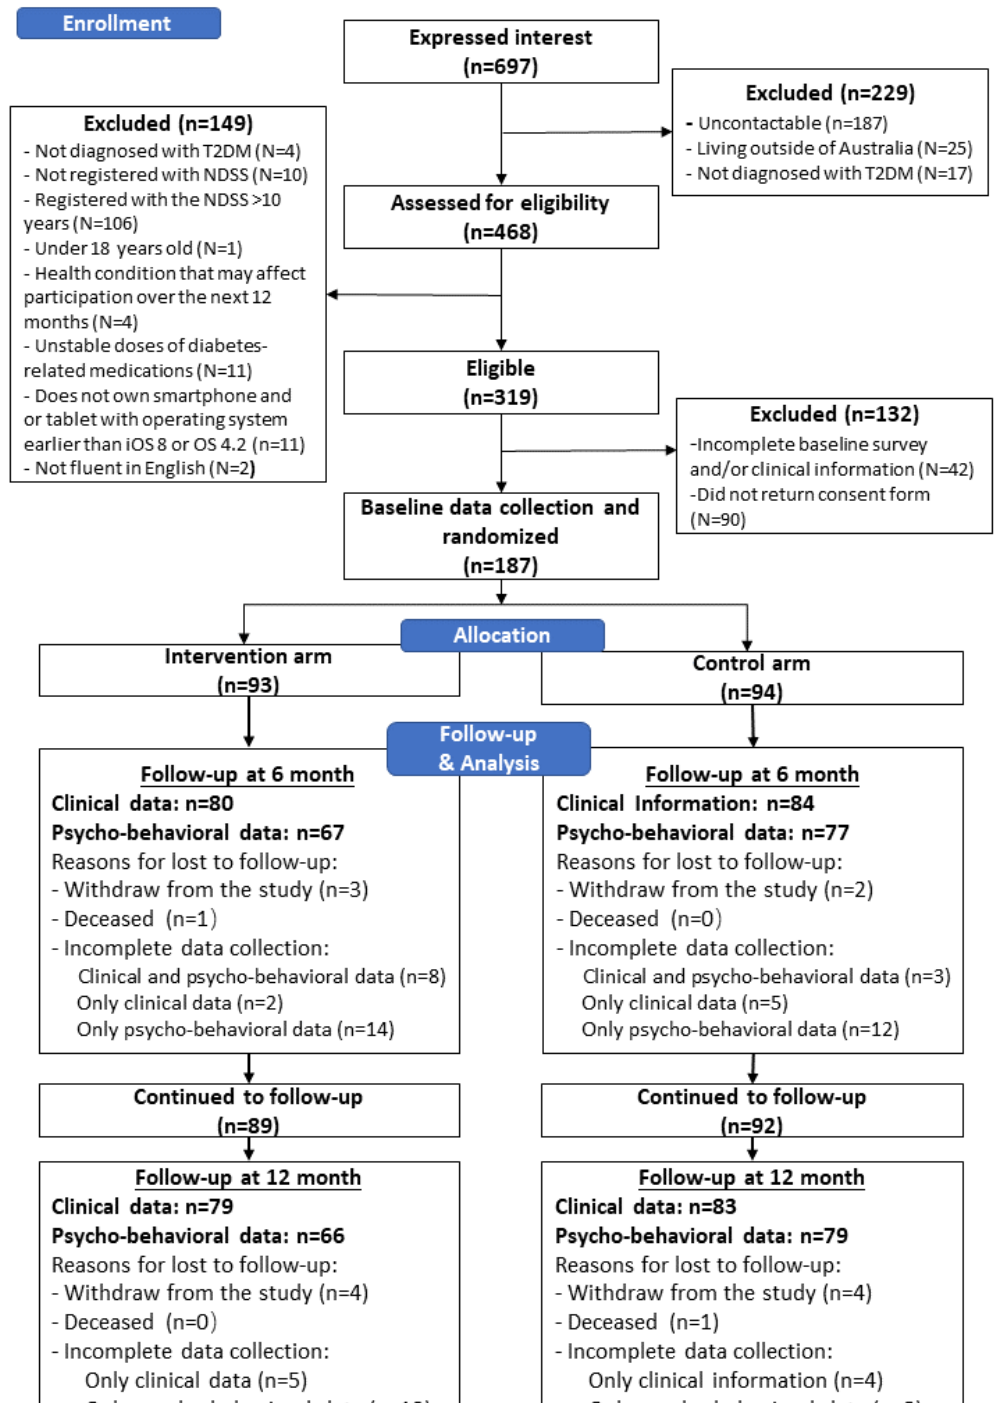
Figure 1. Enrollment, randomization, and follow-up of study